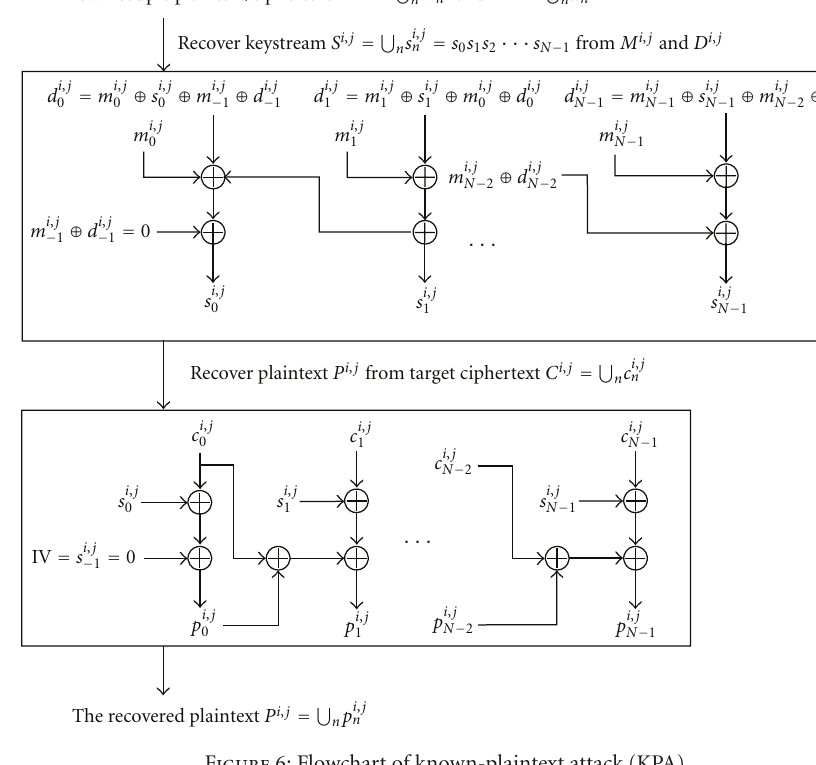
Figure 6: Flowchart of known-plaintext attack (KPA).